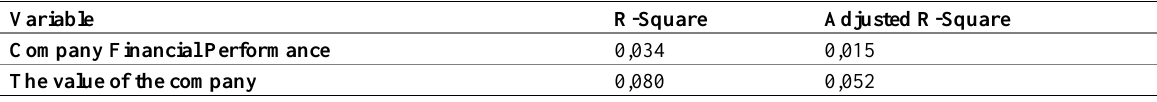
Table 6 : Results of the Structural Model (Inner